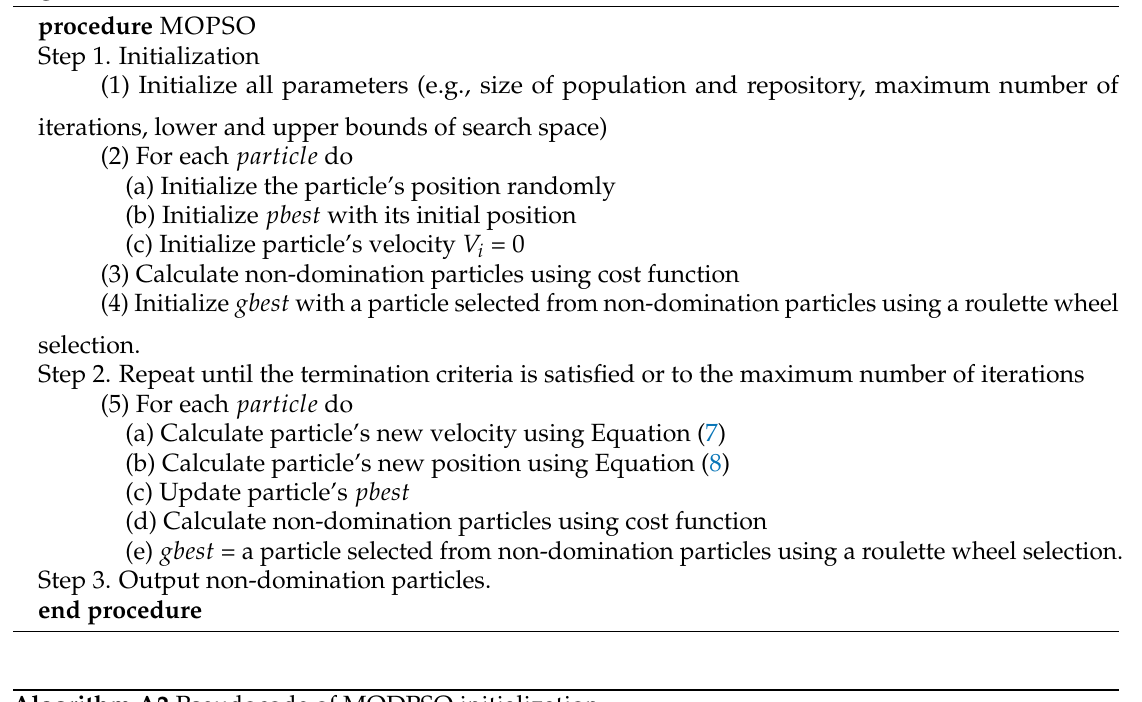
Algorithm A2 Pseudocode of MODPSO initialization